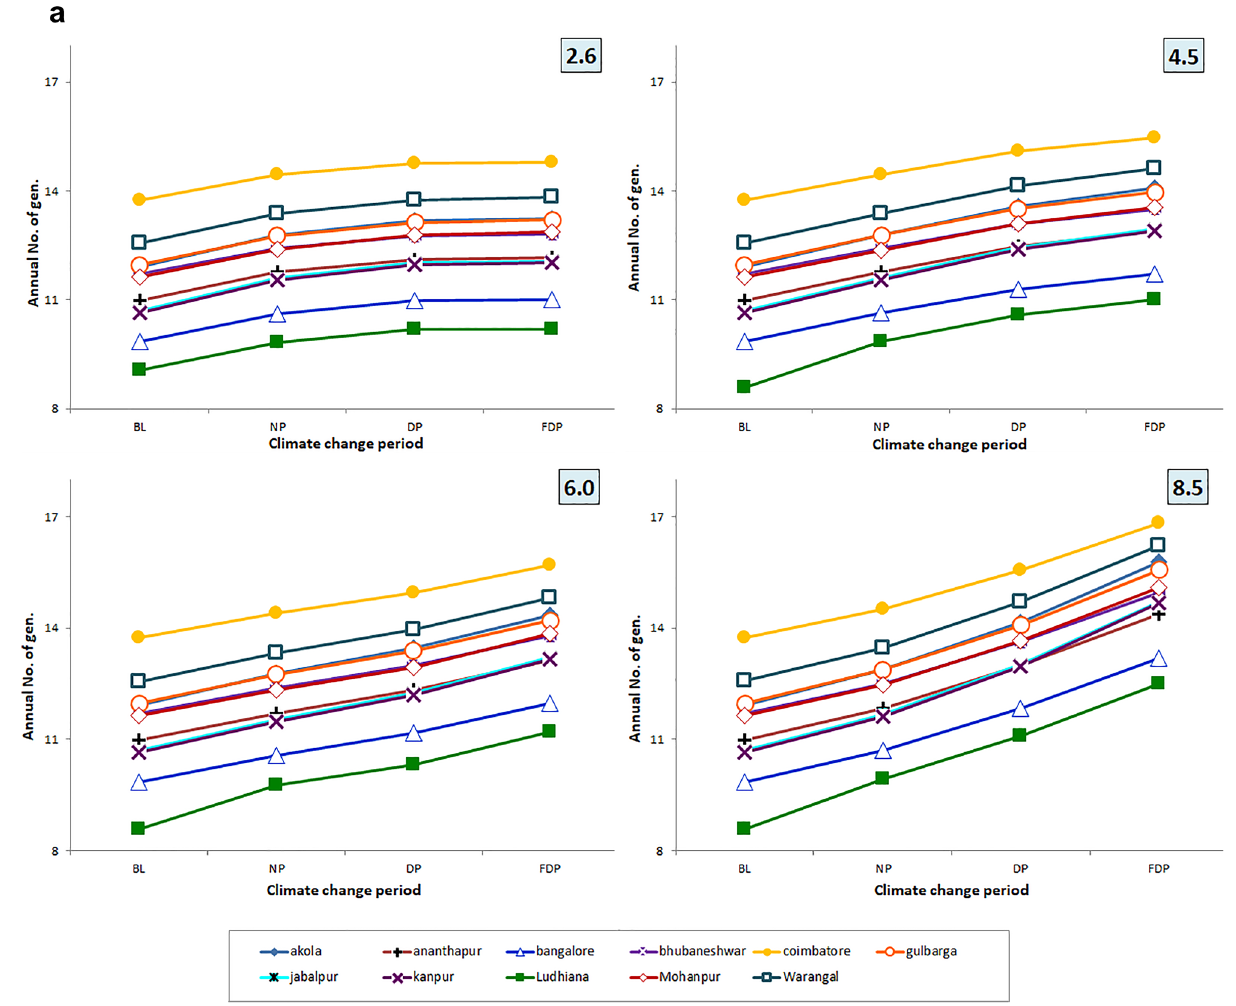
Figure 3. ( a ) Variation in annual no. of gen. of H. armigera during 3 CCPS at 11 pigeonpea growing locations of India. ( b ) Variation in annual gen. time of H. armigera during 3 CCPS at 11 pigeonpea growing locations of